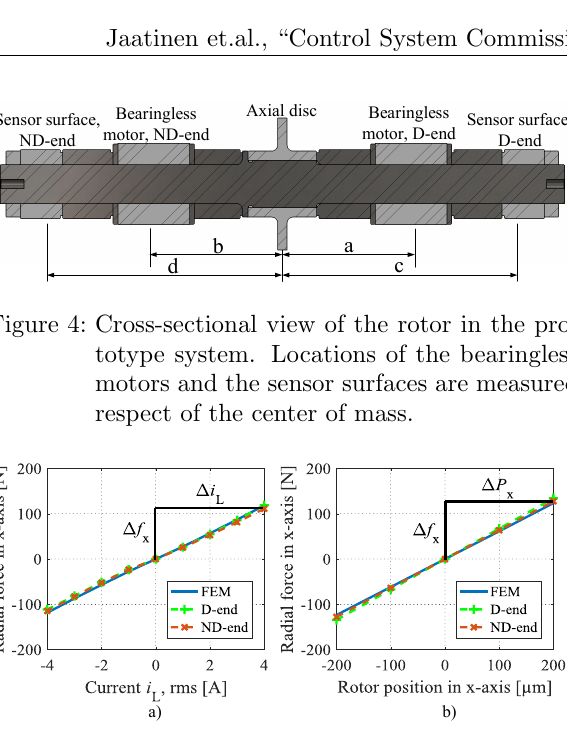
Figure 5: Simulated and measured current and posi- tion stiffnesses. The current stiffness can be calculated from the slope presented in a). In the same manner, the position stiffness can be calculated from the slope presented in